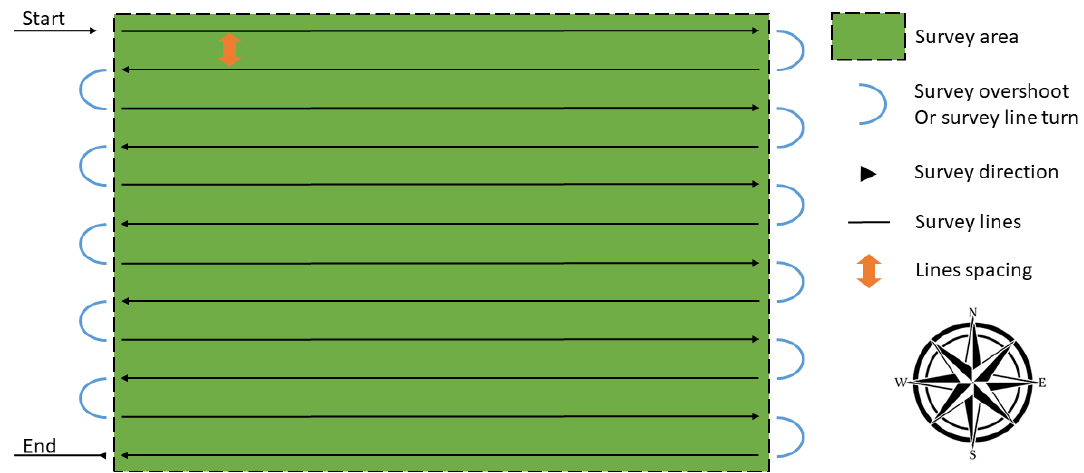
Figure 2. A sketch of a survey design where line spacing, survey heights, and length of survey overshoot are some of the parameters that need to be considered when doing a CSEM survey. Table 1. (A) The estimated temperature effect on parts-per-million values for 40025, 65675, and 91275Hz. The unit is parts per million per degree Celsius (ppm ◦ C − 1 ), which is calculated from the maximum and minimum values for parts-per-million values and temperature. (B) The slope of the linear fit from Fig.